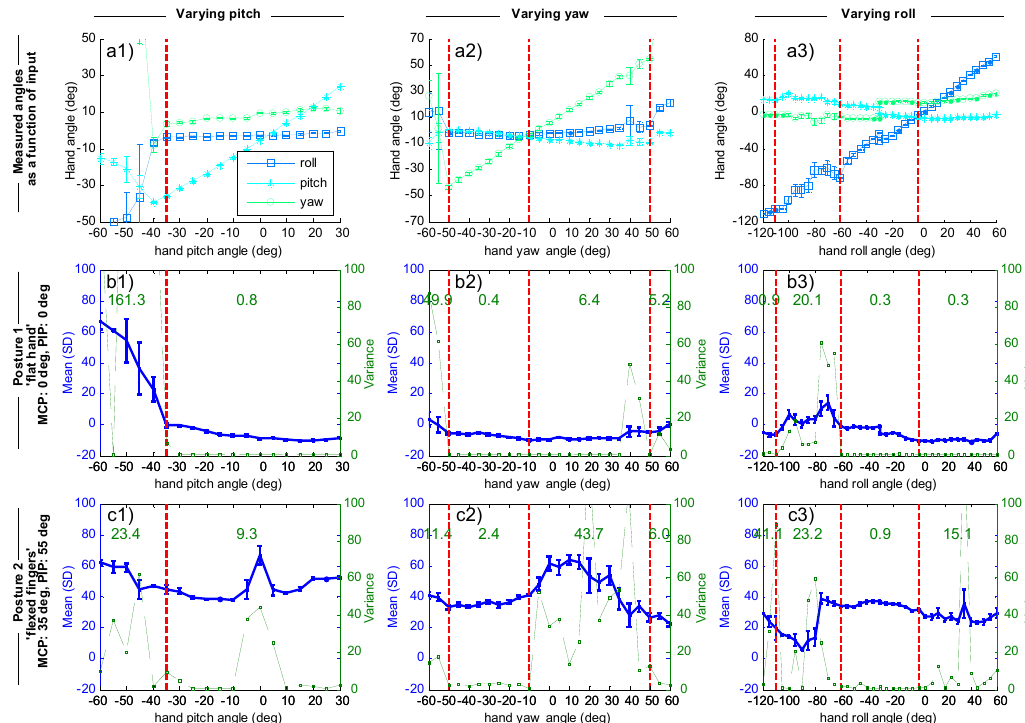
Figure A1. ( a1-a3 ) Measured hand orientations; ( b1-c3 ) metacarpophalangeal (MCP) index finger joint angle as a function of hand orientations (pitch, roll and yaw) for two different postures. (b1-b3) posture 1, flat hand; ( c1-c3 ) posture 2, flexed fingers. Means, standard deviations, and variances were calculated for each of the 5 measurement sessions, and subsequently averaged over all sessions. Posture 1 is with a “flat hand”, MCP 0 deg and proximal interphalangeal (PIP) 0 deg joint angles; posture 2 is with flexed fingers, MCP 35 deg, PIP 55 deg. The thick (blue) line are the measured joint angles. At posture 1 (with MCP 0 deg) one would expect the measurement data as a function of changing hand orientation to be stable around 0 deg, and at posture 2 (with MCP 35 deg) stable around 35 deg. The dashed (green) lines are the measured variances. Vertical thick dashed lines (red) distinguish between stable and unstable orientation ranges, and the therein provided numbers are the mean variances for those ranges. Posture 2, the normalized measurement signal from the Data Glove is used as a weight in scaling up the joint